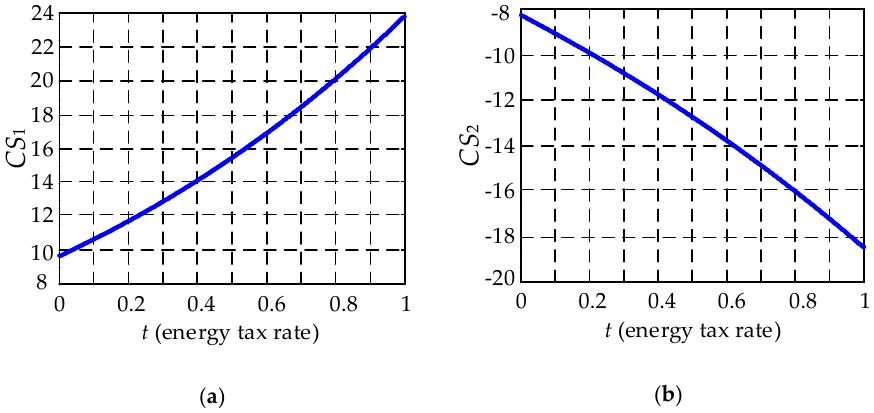
Figure 2. Simulation results of CS: ( a ) CS of Firm 1 vs. the energy tax rate; ( b ) CS of Firm 2 vs. the energy tax rate.